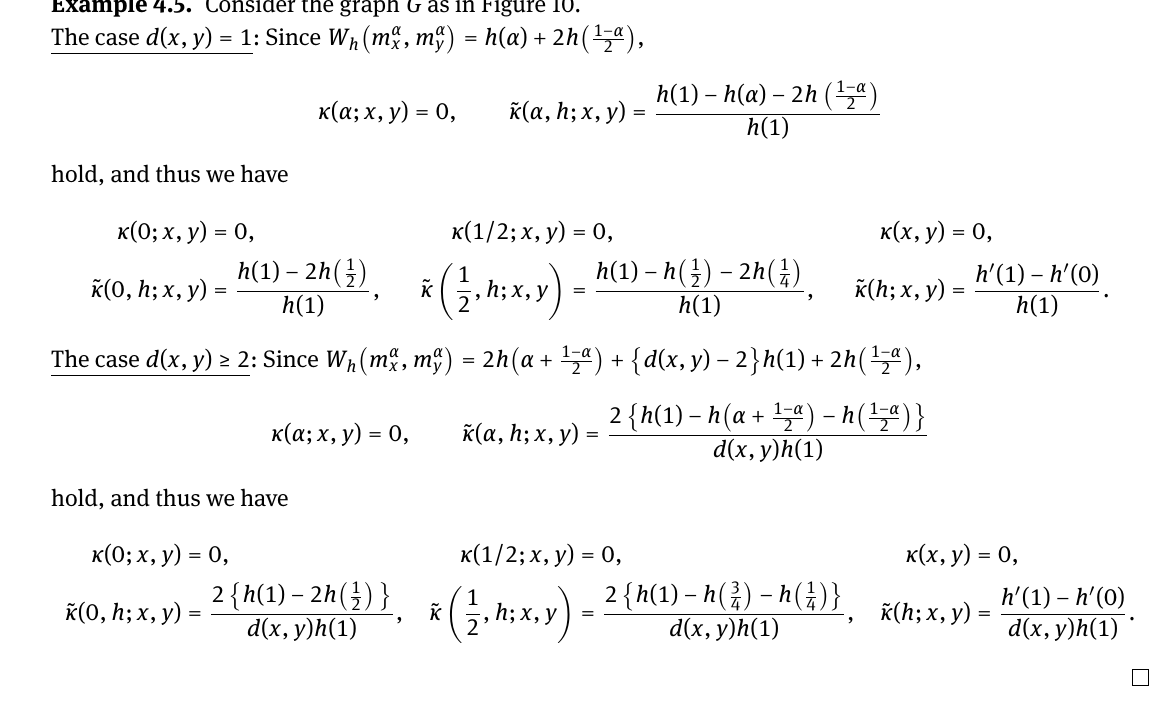
Figure 11: A graph in Z ; G (cid:48) = (cid:0) [ d ( x , y )] 0 , E (cid:48) (cid:1) , E (cid:48) := (cid:8) ( (cid:96) − 1, (cid:96) ) (cid:12) (cid:12) (cid:96) ∈ [ d ( x , y )] (cid:9)